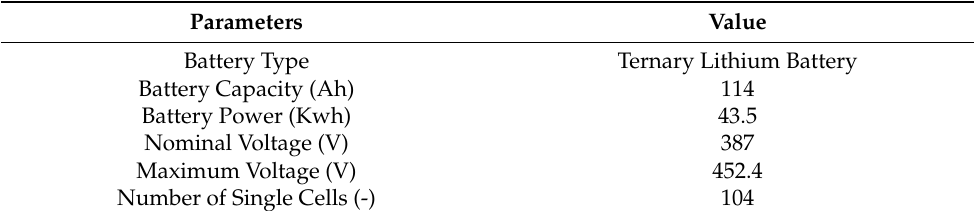
Table 3. General parameters of the high-voltage battery pack.